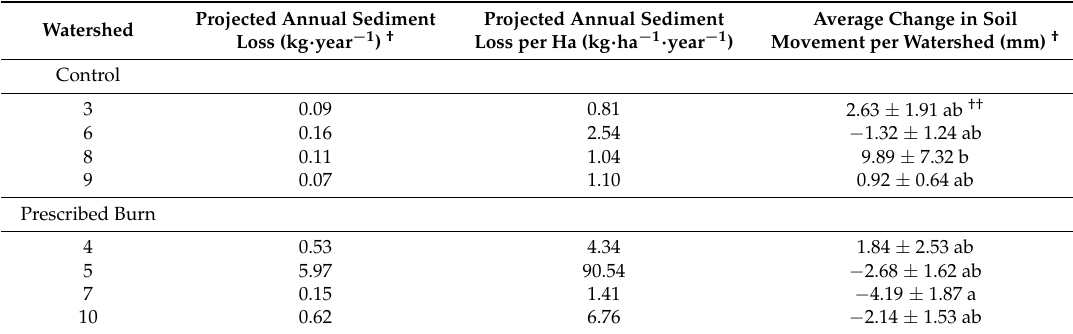
Table 5. Projected annual sediment loss from the watersheds during the post-burn phase and annual soil movement measured by erosion pins in all watersheds at Trail of Tears State Forest,